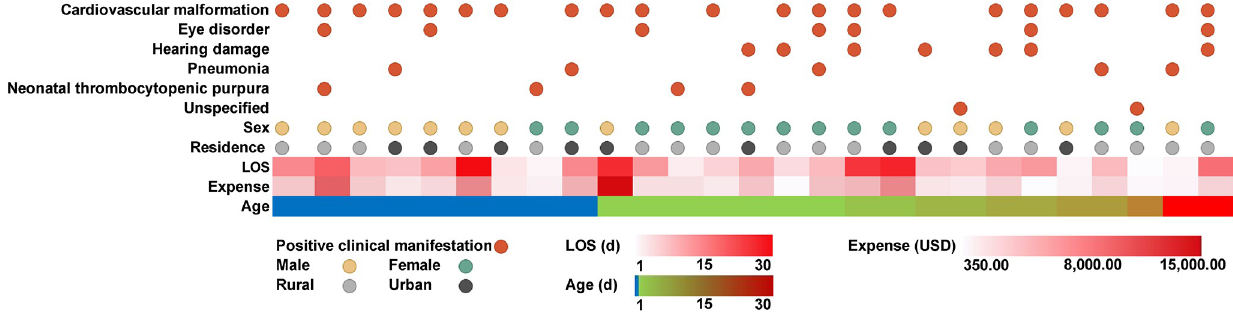
Fig 2. LOS and expenses of hospitalization due to